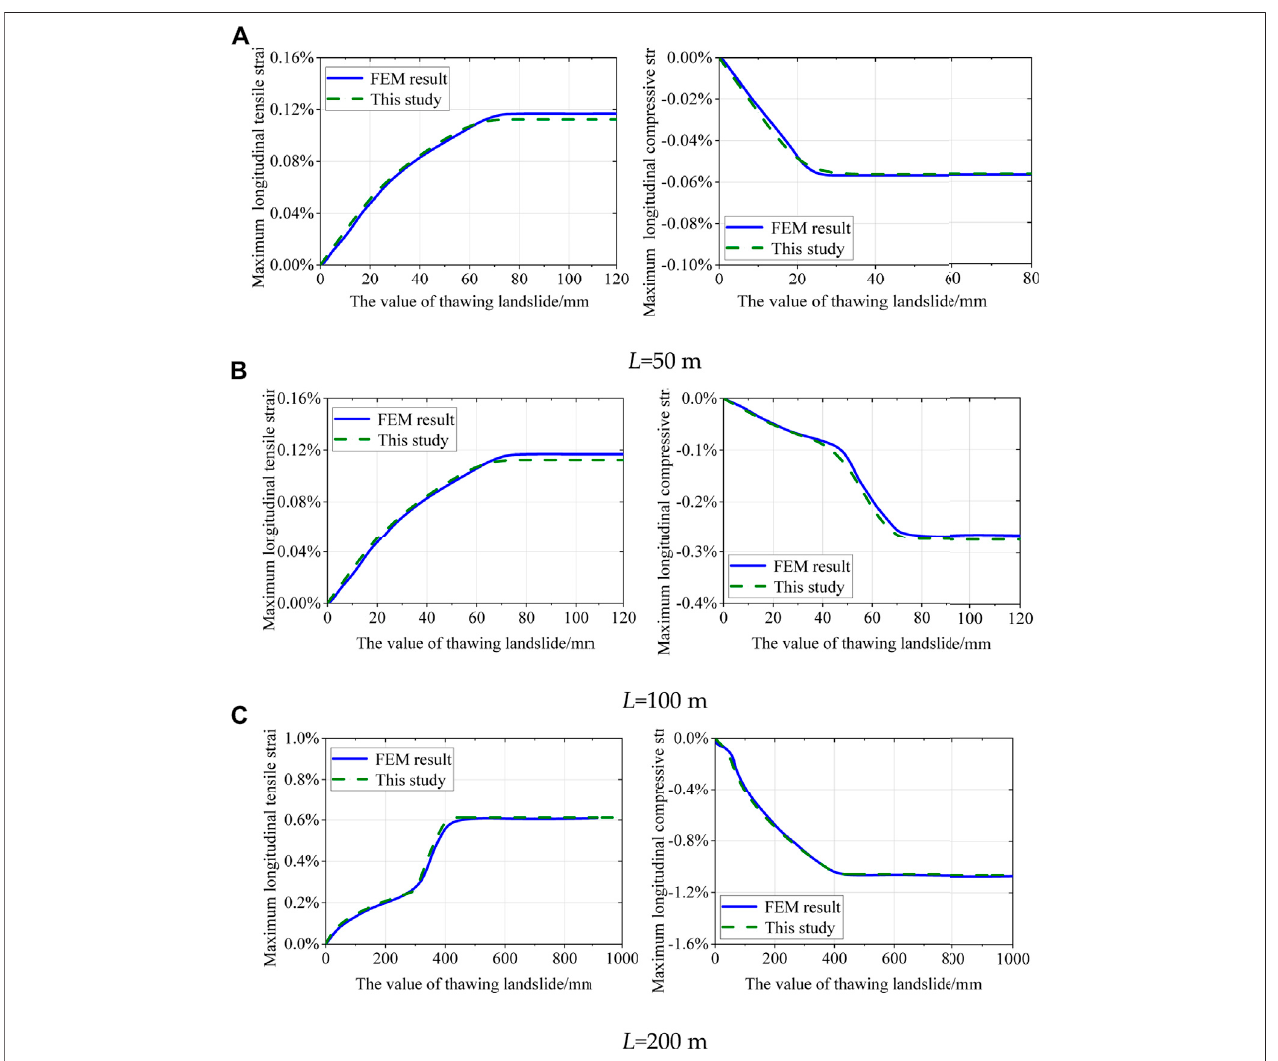
FIGURE 11 | The result verification of the maximum longitudinal strain in the pipeline with (A) L (cid:1) 50 m, (B) L (cid:1) 100 m, and (C) L (cid:1) 200 m.